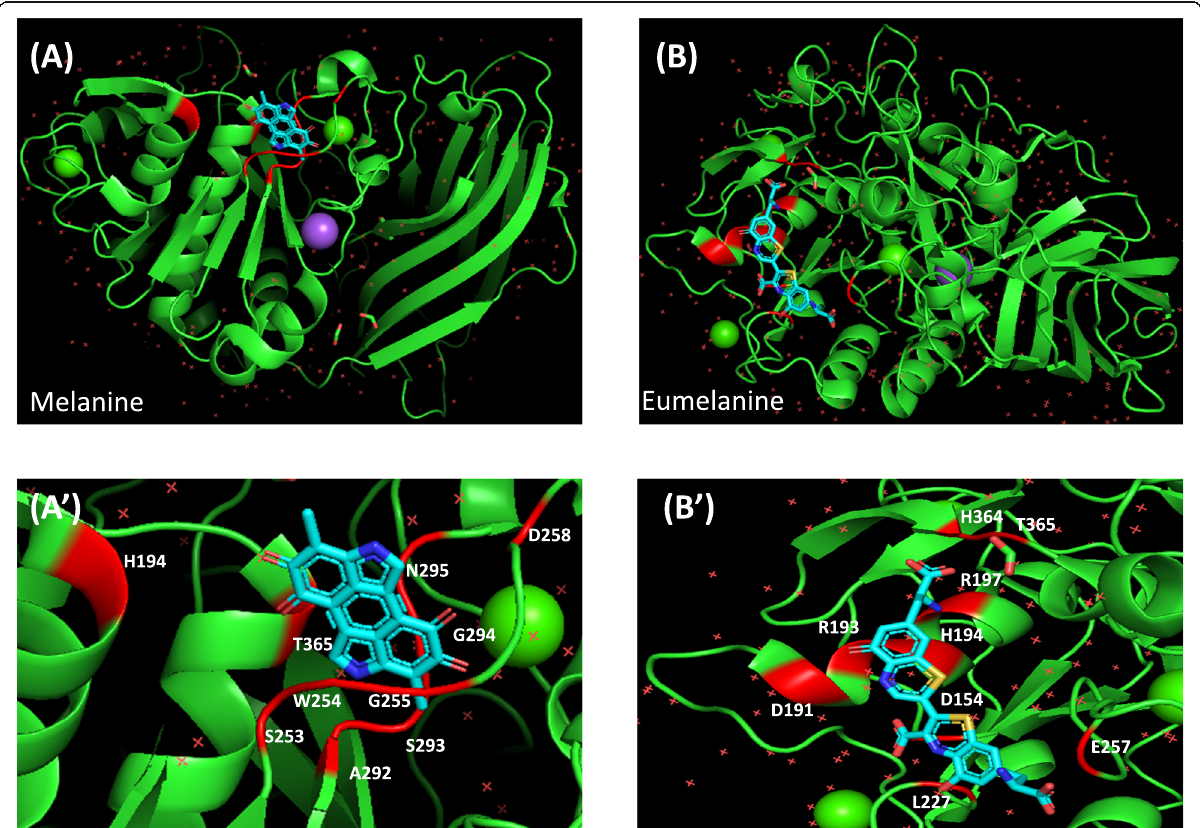
Fig. 4 Docked image ofHuman Furin (PDB ID: 4RYD) with Melanine viewed in in PyMO ( A ). Zoomed image of ligand binding site of Furin- Melanine complex ( A ’ ).Docked image of Human Furin (PDB ID: 4RYD) with Eumelanine viewed in in PyMO ( B ). Zoomed image of ligand binding site of Furin-Eumelanine complex ( B ’